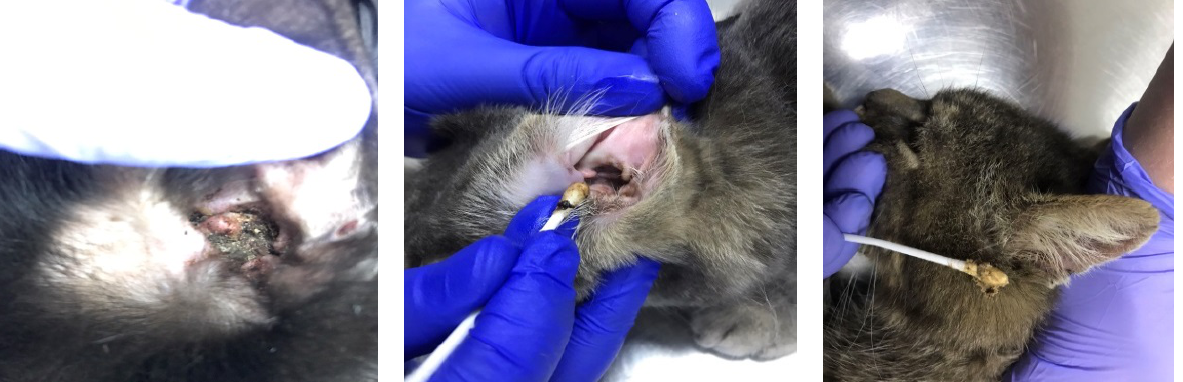
Fig. 3. Otodect е s cynotis mite in a cat's